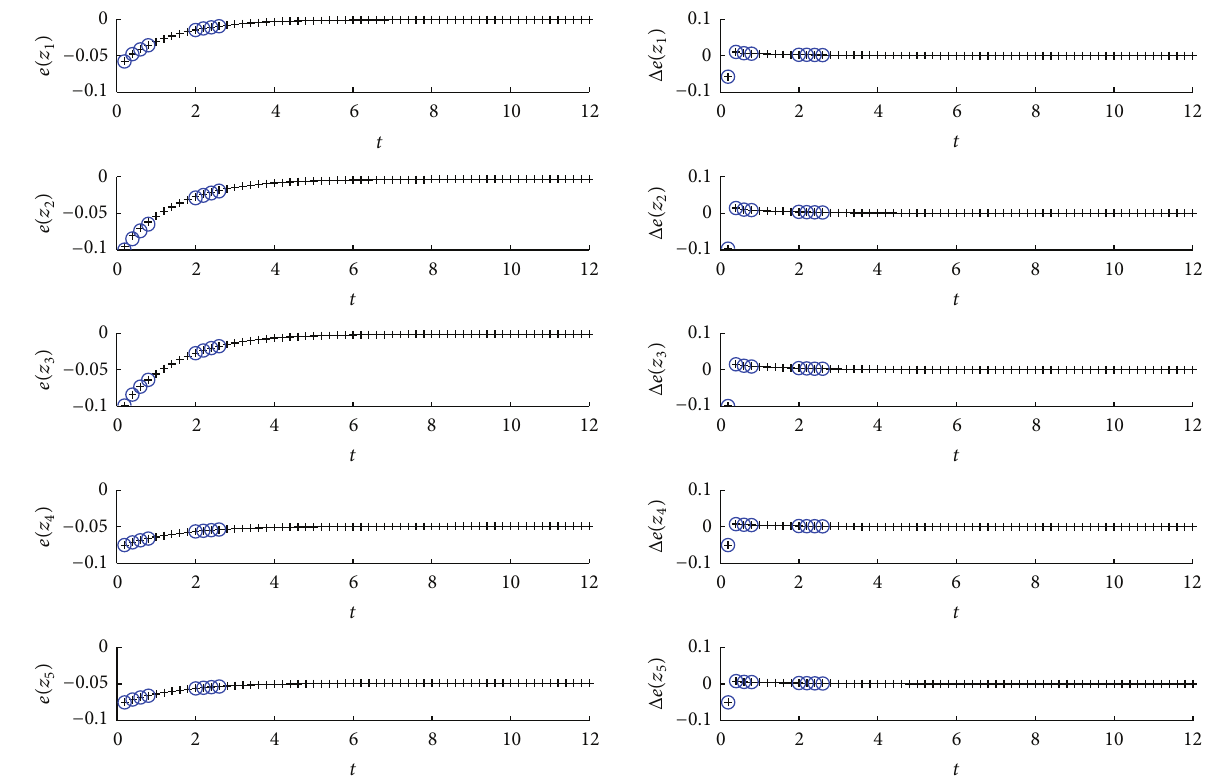
Figure 7: Input data and support vectors from each sensing location. Circle (o): support vector; dot (+): input data.